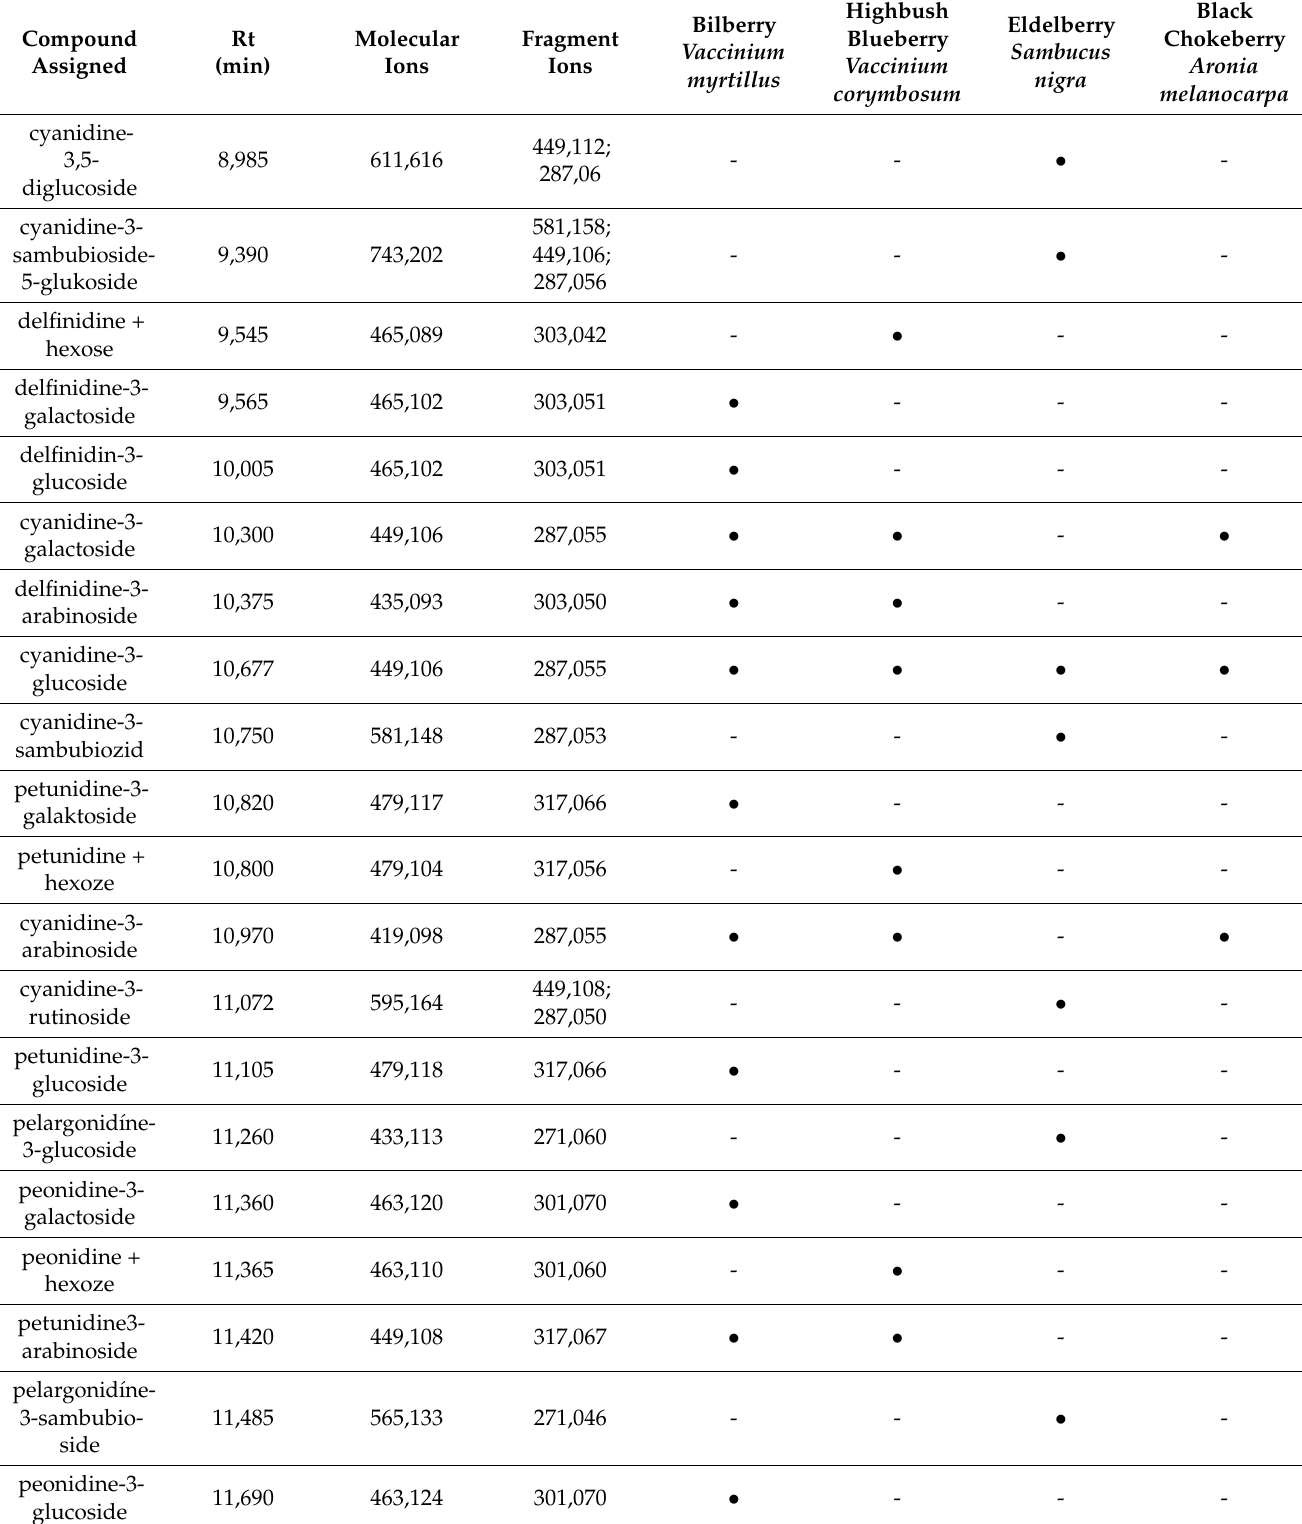
Table 1. Anthocyanin contents of elderberry lyophilizates in regard to ethanolic fruit extract ( • : presence; -: absence).